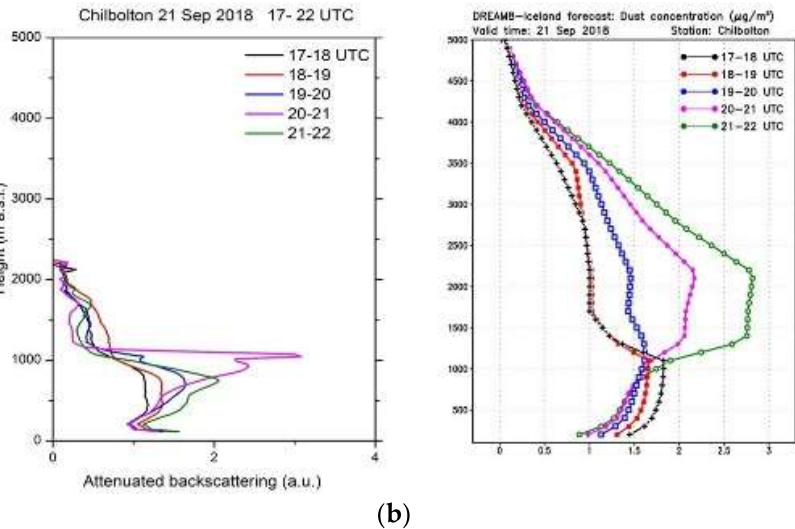
Figure 16. Chilbolton station: ( a ) Time series of the model dust concentration (µgm −3 ) (upper) and ceilometer attenuated backscatter (lower), along with aerosol type classification inferred using air mass back trajectories; and ( b ) vertical profiles of the attenuated backscattering calculated from the ceilometer observations (left) and of the dust concentration (µgm −3 ) predicted by the model (right) for selected time intervals. Note: Boxes in the model images are approximately positioned in accordance to those specified in the LIDAR/ceilometer analysis plot.